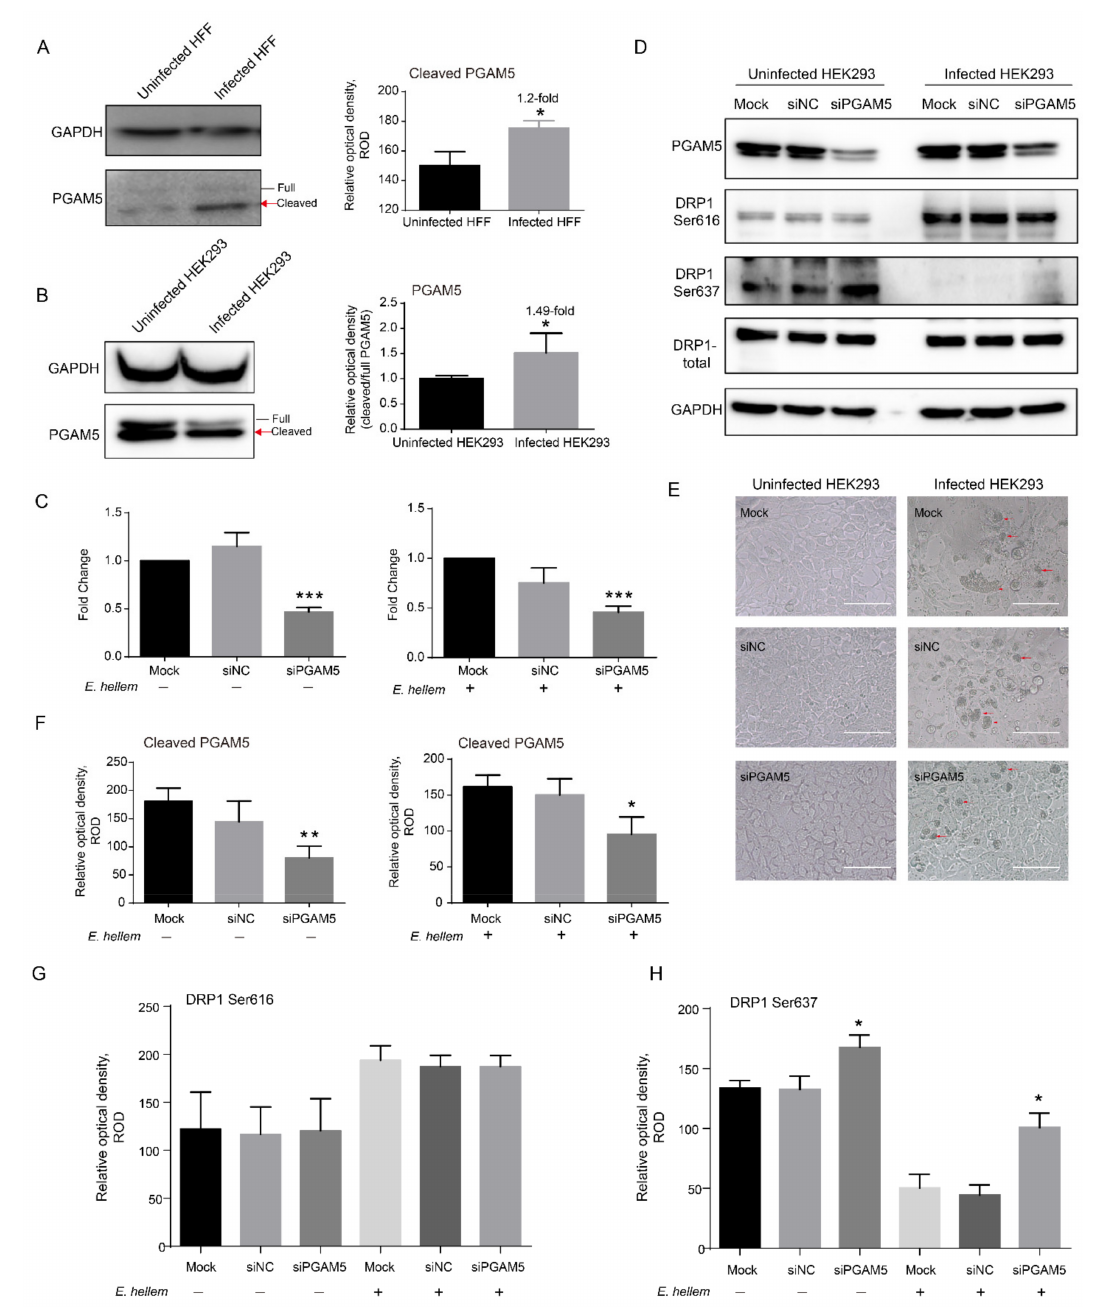
Figure 7. The activation of PGAM5 by E. hellem . Western blot analysis of the activation of PGAM5 in E. hellem -infected HFF ( A ) and HEK293 ( B ) cells at 48 hpi, respectively. GAPDH was used as an internal control. Red arrows mark the cleaved PGAM5 bands with significant changes. The relative optical density of cleaved PGAM5 bands was determined and statistically compared. ( C ) Transcript level of PGAM5 . GAPDH used as an internal control gene. Mock, no treatment; NC, Negative control. ( D ) Western blot analysis of the dephosphorylation and phosphorylation of DRP1 with knockdown PGAM5 at 36 h. Simultaneously, the light-observed HEK293 cells are shown in the lower panels ( E ). Arrows indicate the PV of E. hellem . Bar, 50 µ m. ( F ) The relative optical density of cleaved PGAM5 immune blots. ( G ) Statistical analysis of the relative optical density of immune blots for DRP1 Ser616. ( H ) Statistical analysis of the relative optical density of immune blots for DRP1 Ser637. * p < 0.05; ** p < 0.01; *** p <